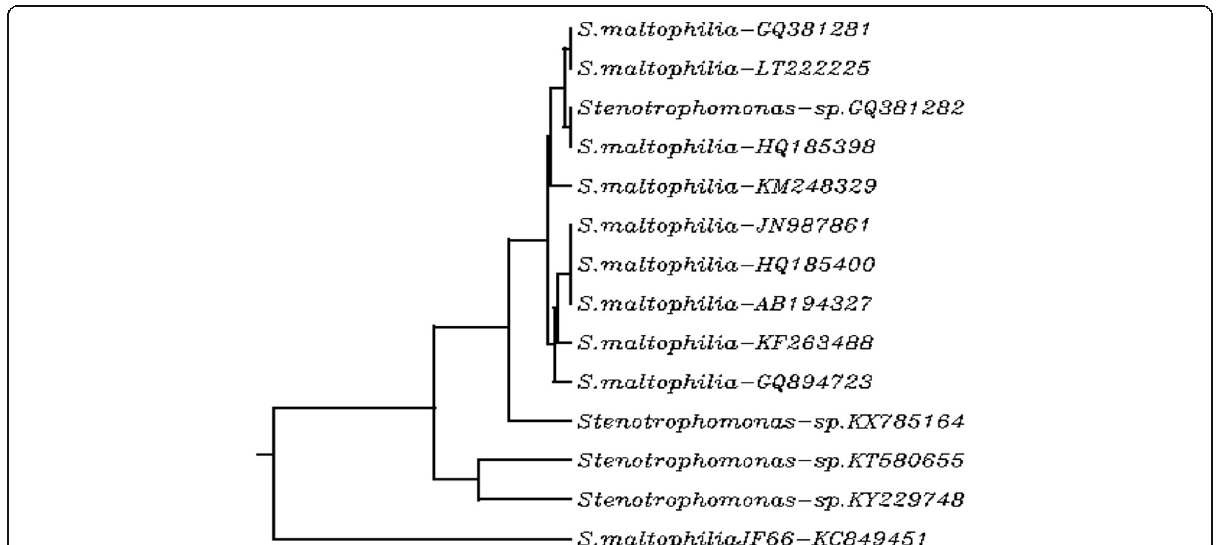
Fig. 1 Phylogenetic tree of the isolate showing highest homology with Stenotrophomonas sp. consensus neighbor-joining phylogenetic rooted tree from sequences of the 16S rRNA gene, encompassing S .